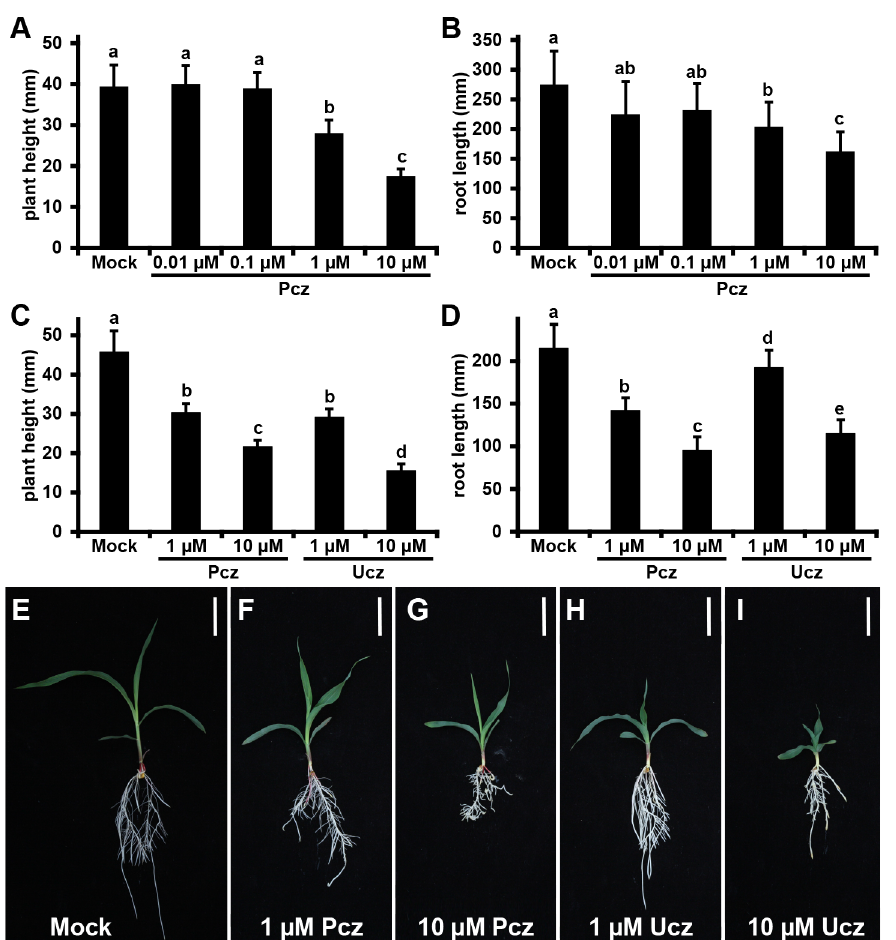
Figure 9. Plant growth responses of maize seedlings treated with Pcz or Ucz grown in an aeroponic culture system. B73 maize seedlings were germinated and grown as described in Material and Methods and treated with (A–B) Mock conditions, 0.01 m M Pcz, 0.1 m M Pcz, 1 m M Pcz, or 10 m M Pcz. A second set of plants was treated with (C–D) Mock, 1 m M Pcz, 10 m M Pcz, 1 m M Ucz, or 10 m M Ucz. (A,C) plant height measured from the top of the mesocotyl to the second leaf collar. (B,D) length of the primary root measured from the root tip to the root-shoot transition zone. All plants were grown in aeroponic culture (see also Fig. S3). Error bars represent standard deviation. Statistical analysis was performed by ‘‘Post Hoc’’ and indicated by lowercase letters (p , 0.05). (E–I) Photographic images of seedlings grown in aeroponic culture. Seedlings were grown in the presence of (F) 1 m M Pcz, (G) 10 m M Pcz, (H) 1 m M Ucz, and (I) 10 m M Ucz. Scale bars indicate 5